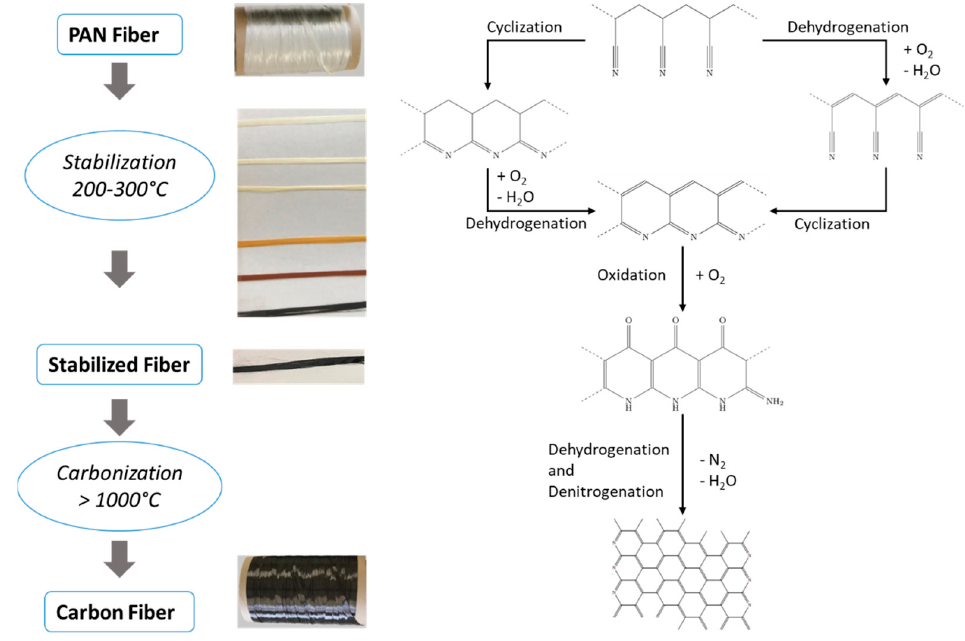
Figure 1. Reaction schematic of the stabilization stage